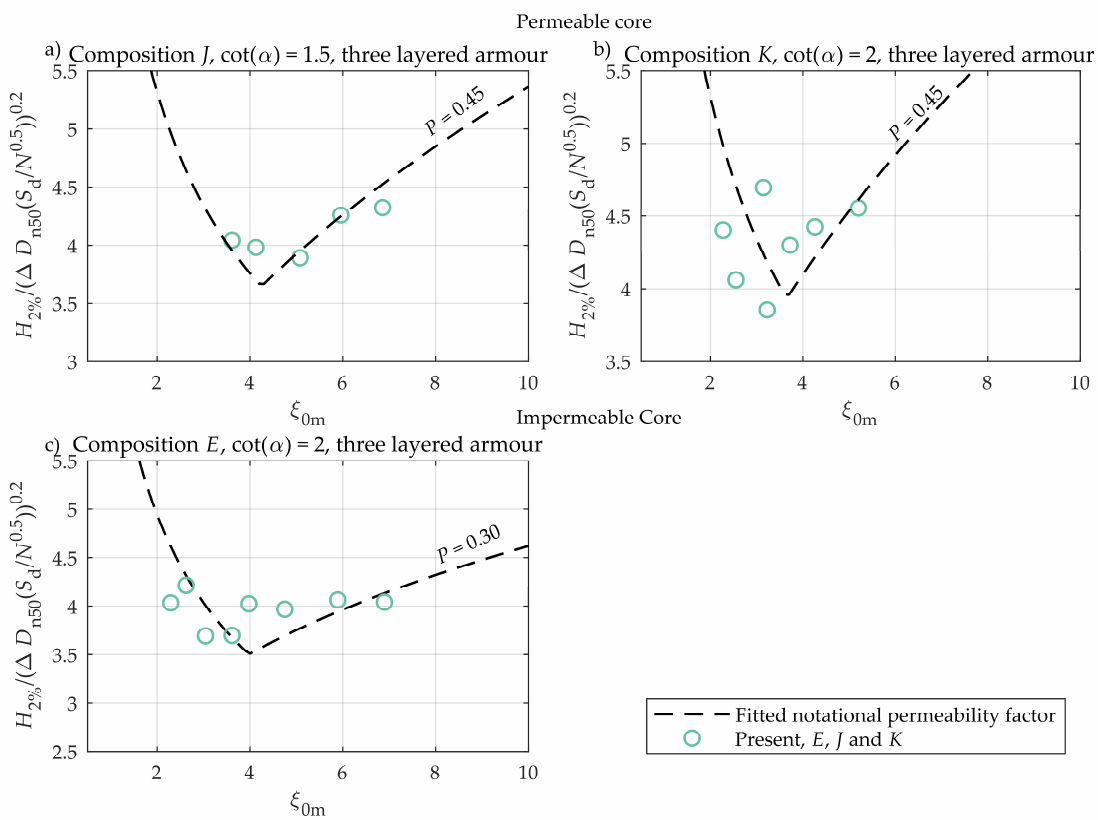
Figure 12. Tests with layer compositions J , K and E and front slope of cot( α ) = 1.5 and 2. Dashed lines indicate fitted values of P derived from the Van der Meer [1] formulae. Markers indicate the results.